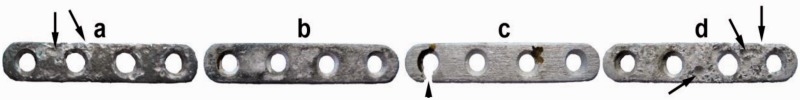
In vivo degradation morphology of bone plates fabricated with (a) JDBM, (b) JDBM covered with brushite coating, (c) AZ31 and (d) WE43, at 18 weeks post-implantation into rabbits